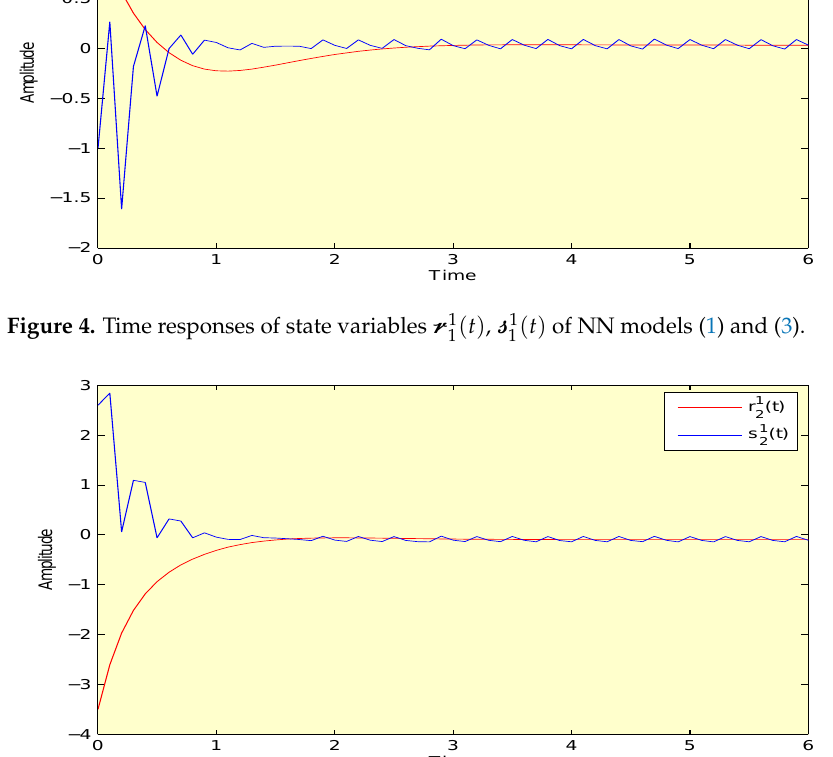
( t ) , (cid:115) 1 ( t ) of NN models (1) and (3). 2 2